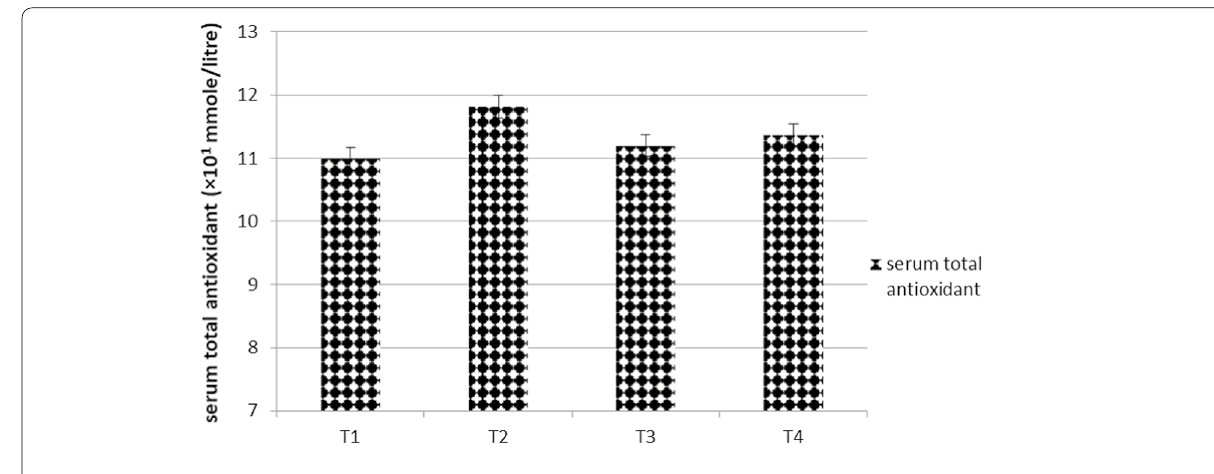
Fig. 4 Serum total antioxidant profile of rabbit bucks after the administration of ascorbic acid and sodium bicarbonate. T1-control, T2-ascorbic acid, T3-sodium bicarbonate, T4-ascorbic acid